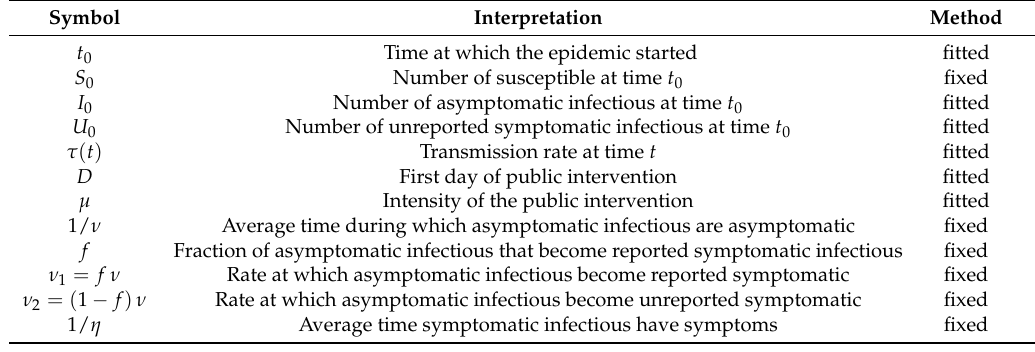
Table 3. Parameters of the model.